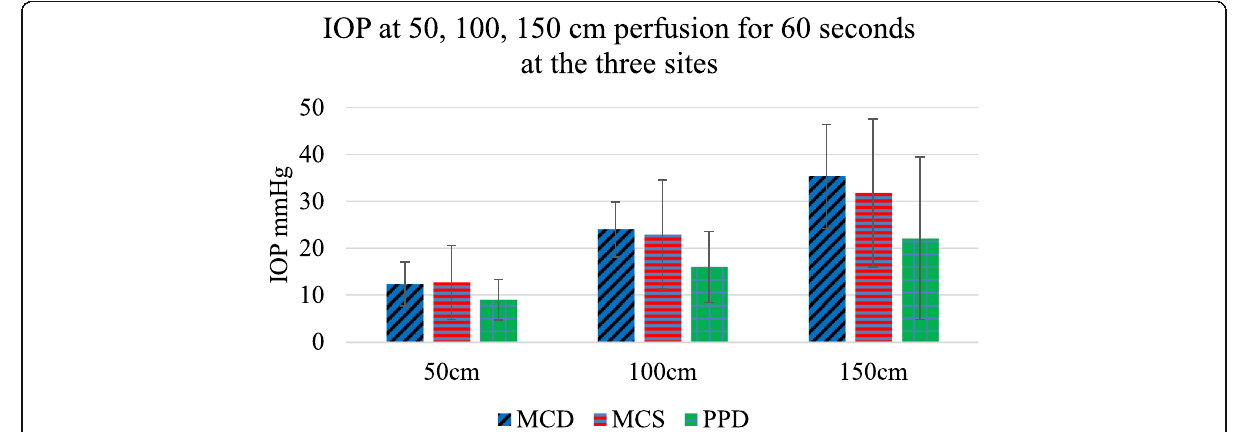
Fig. 1 Difference in IOP at 60 s perfusion at the different sites tested, Blue - MCD - metacarpal diaphysis, Red - MCS - metacarpal subchondral, Green - PPD - proximal phalanx diaphysis n = 40 sites in 15 subjects. For each individual site IOP was correlated with perfusion pressure, r = 0.993, error bars